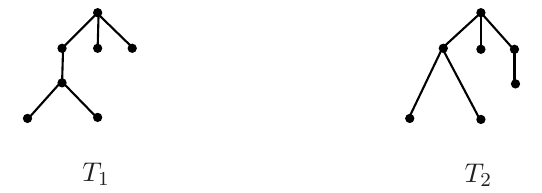
Figure 1: The trees T 1 and T 2 satisfying irr t ( T 1 ) = irr t ( T 2 ) = 22 and HA ( T 1 ) = 44 / 3 , HA ( T 2 ) = 43 / 3